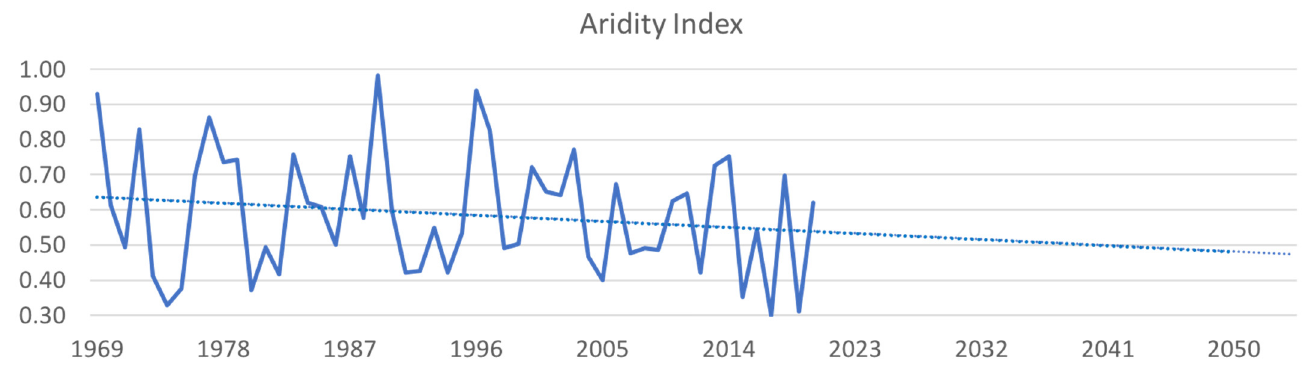
Figure 2. Boxplot chart for the climate normals 1981–2010 and 1991–2020.